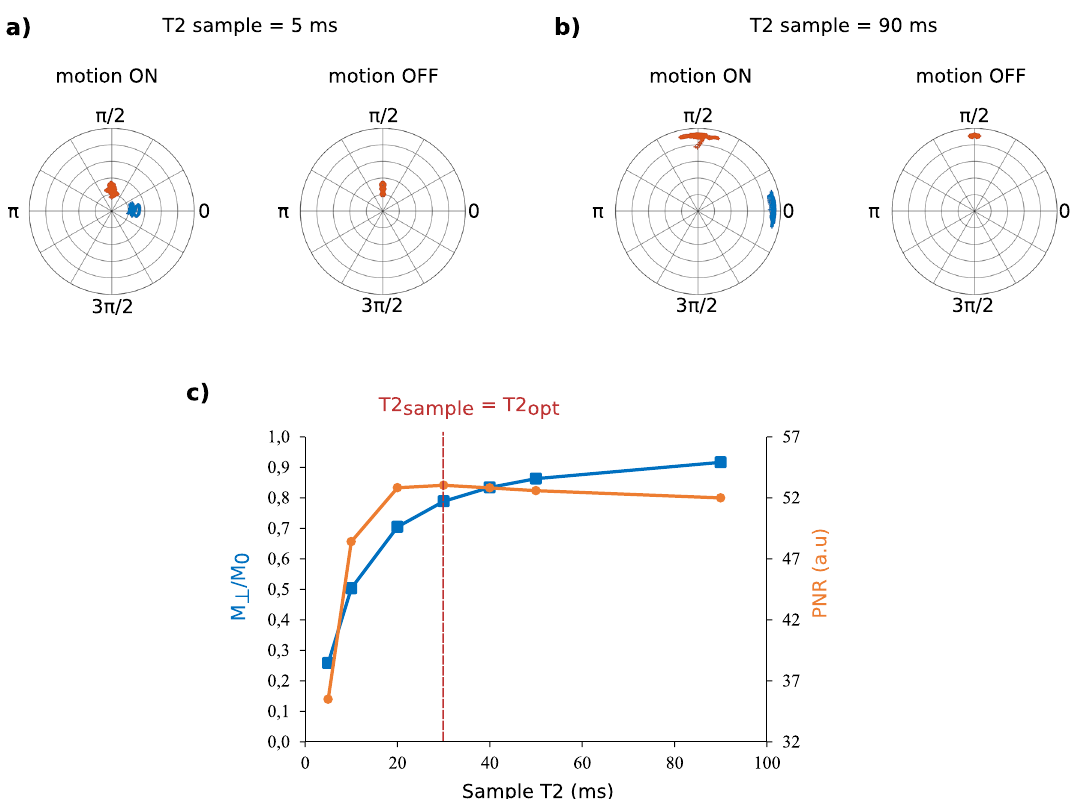
Figure 4. Numerical evaluation of the robustness of the OC pulse A (T2 opt = 30 ms) with respect to the variability of the sample T2-value. Final transverse magnetization states are presented in Bloch spheres when applying the OC pulse with and without motion for samples with T2-values of ( a ) 5 ms and ( b ) 90 ms. ( c ) Simulated transverse magnetization amplitude and PNR variation with respect to sample